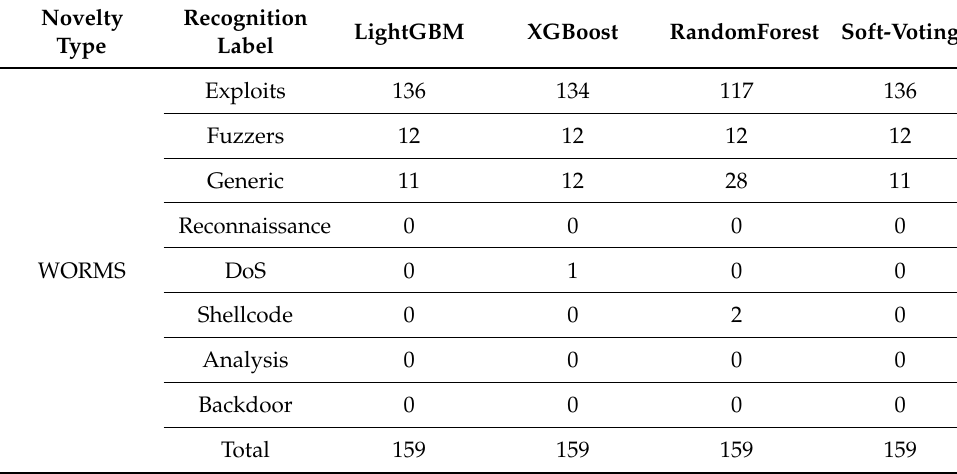
Table 14. Ensemble model on novelty set